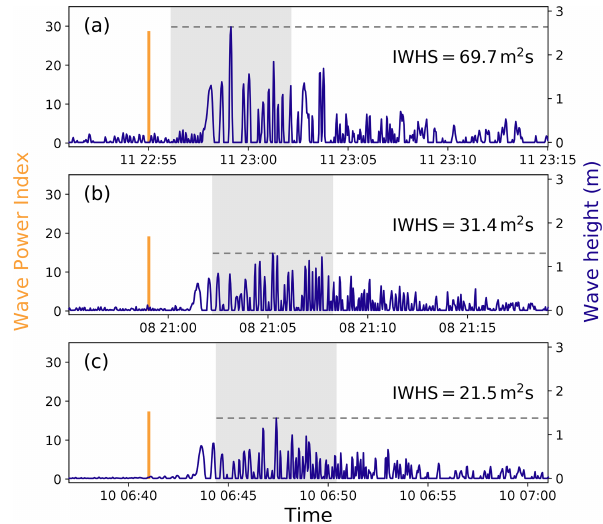
Figure B1. Timing of the three highest wave power indexes (or- ange bars; a – c in WPI descending order) determined by TeRACWA and associated wave heights derived from pressure sensor data (blue curves). Gray dashed lines indicate the maximum wave heights, and gray areas show the ± 3min intervals around maximum wave height used in the IWHS computation.